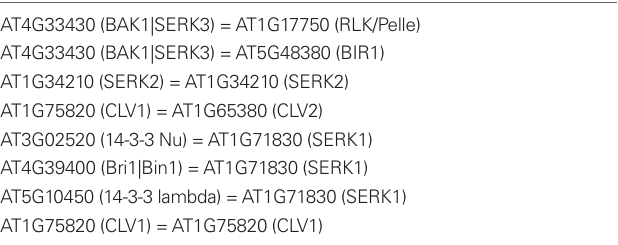
Table 1 | Published interactions (Popescu, intact, Biogrid, or TAir) that were not found in our